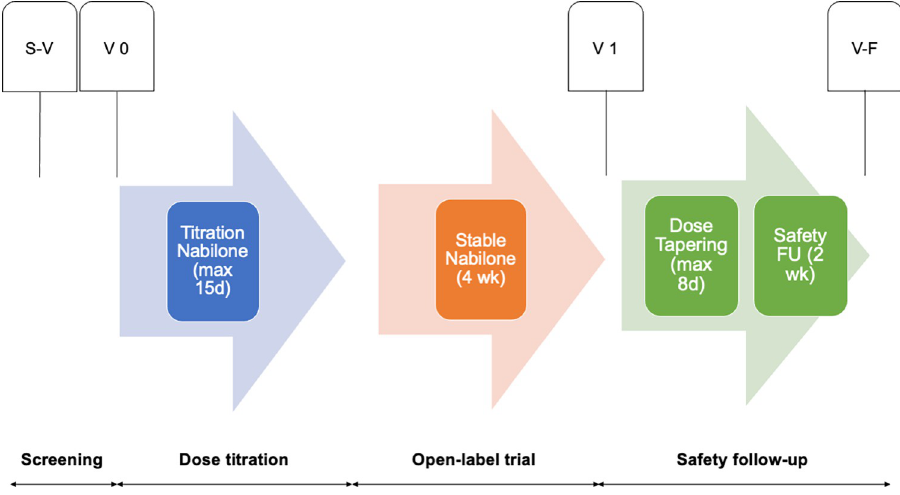
Fig 2. A schematic diagram of the trial design, including all study visits and timeline. Abbreviation: S-V: screening visit; V 0: baseline visit; V 1: visit at the end of open-label phase; V-F: follow-up visit to ensure safety; d: days; wk: weeks; FU: follow-up; max: